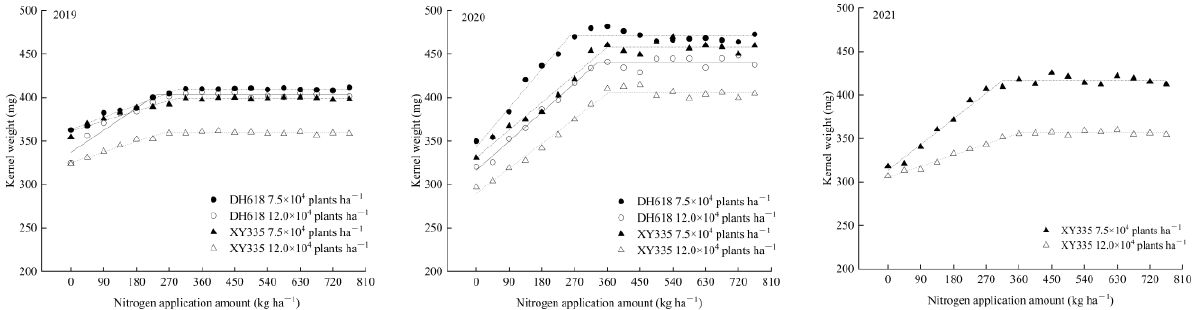
Figure 2. Effects of different nitrogen application rates on maize kernel weight.